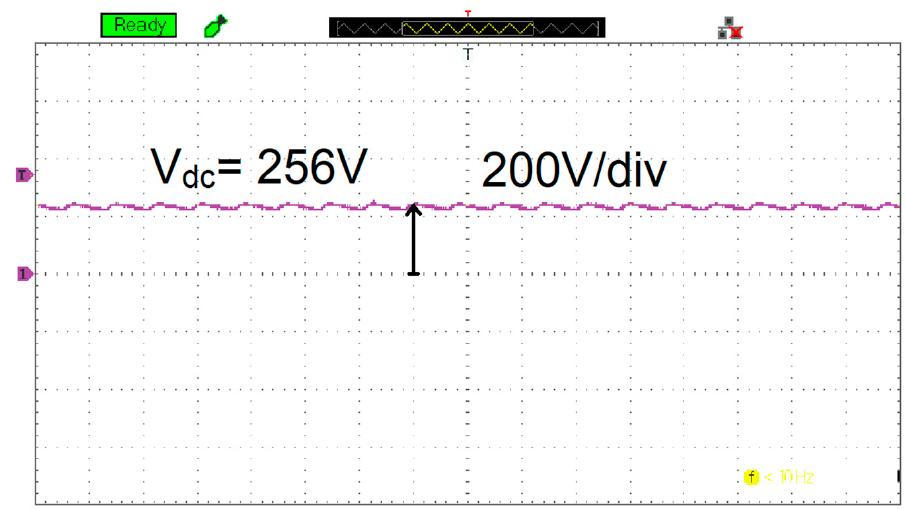
Figure 20. Output voltage of DAB converter.